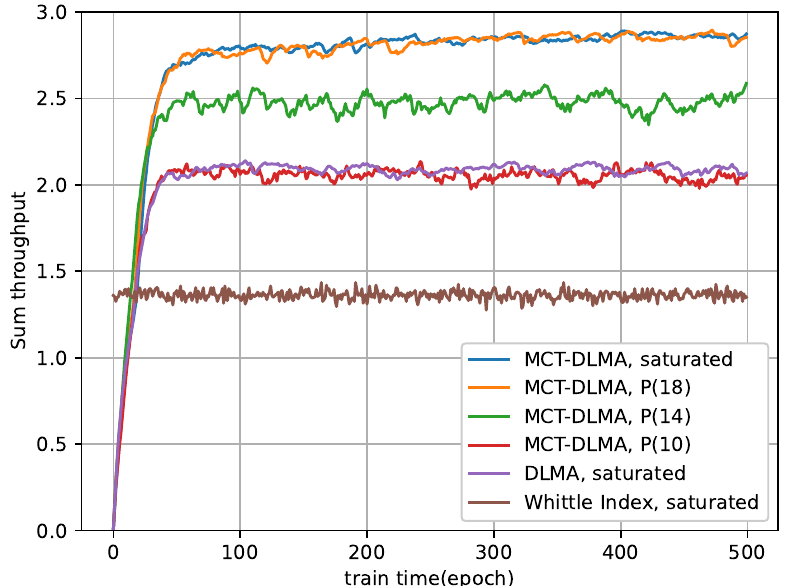
Figure 4. Sum throughput when CU coexists with three TDMA